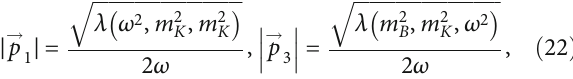
ffiffiffiffiffiffiffiffiffiffiffiffiffiffiffiffiffiffiffiffiffiffiffiffiffiffiffiffiffi